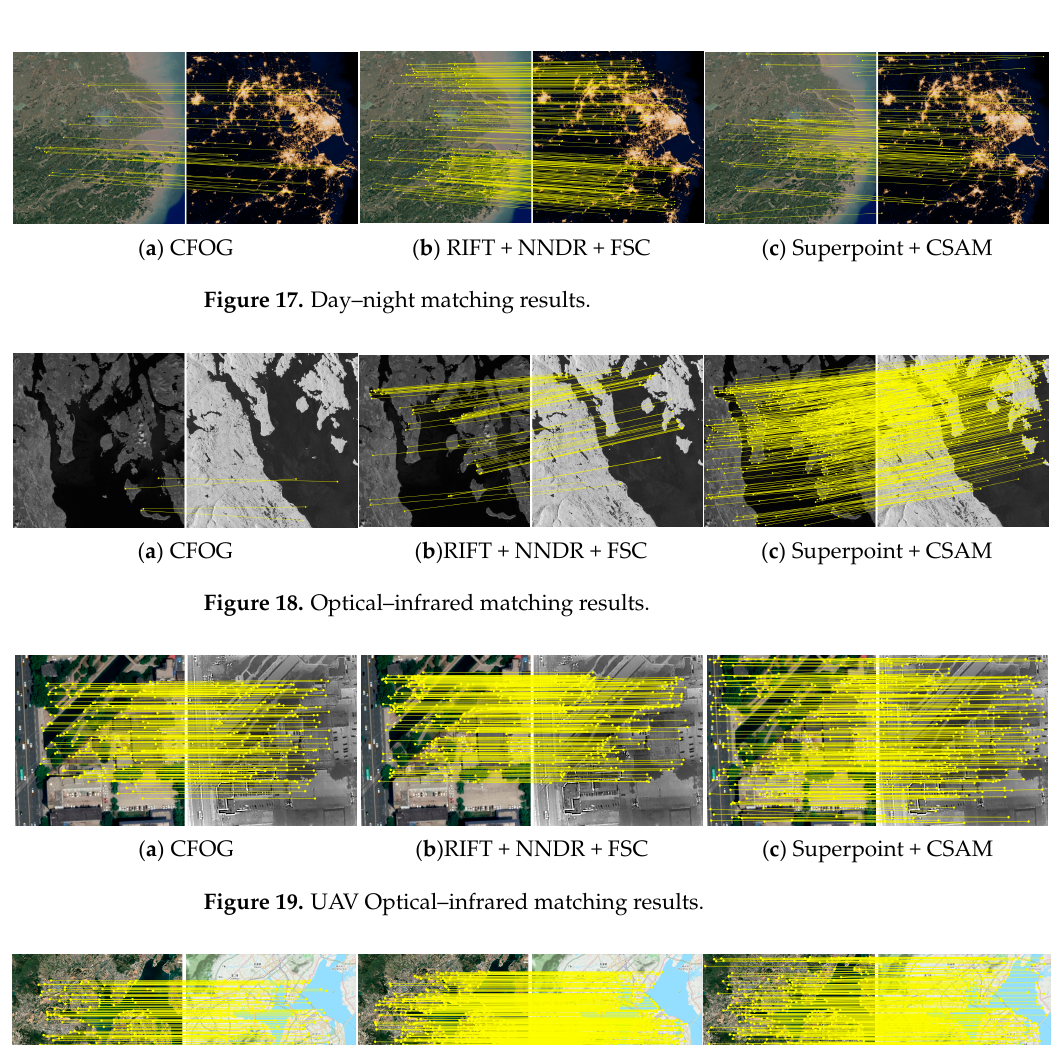
( f ) Optical – LiDAR Figure 15. Test image pairs. Table 3. The NCM of different methods. Category